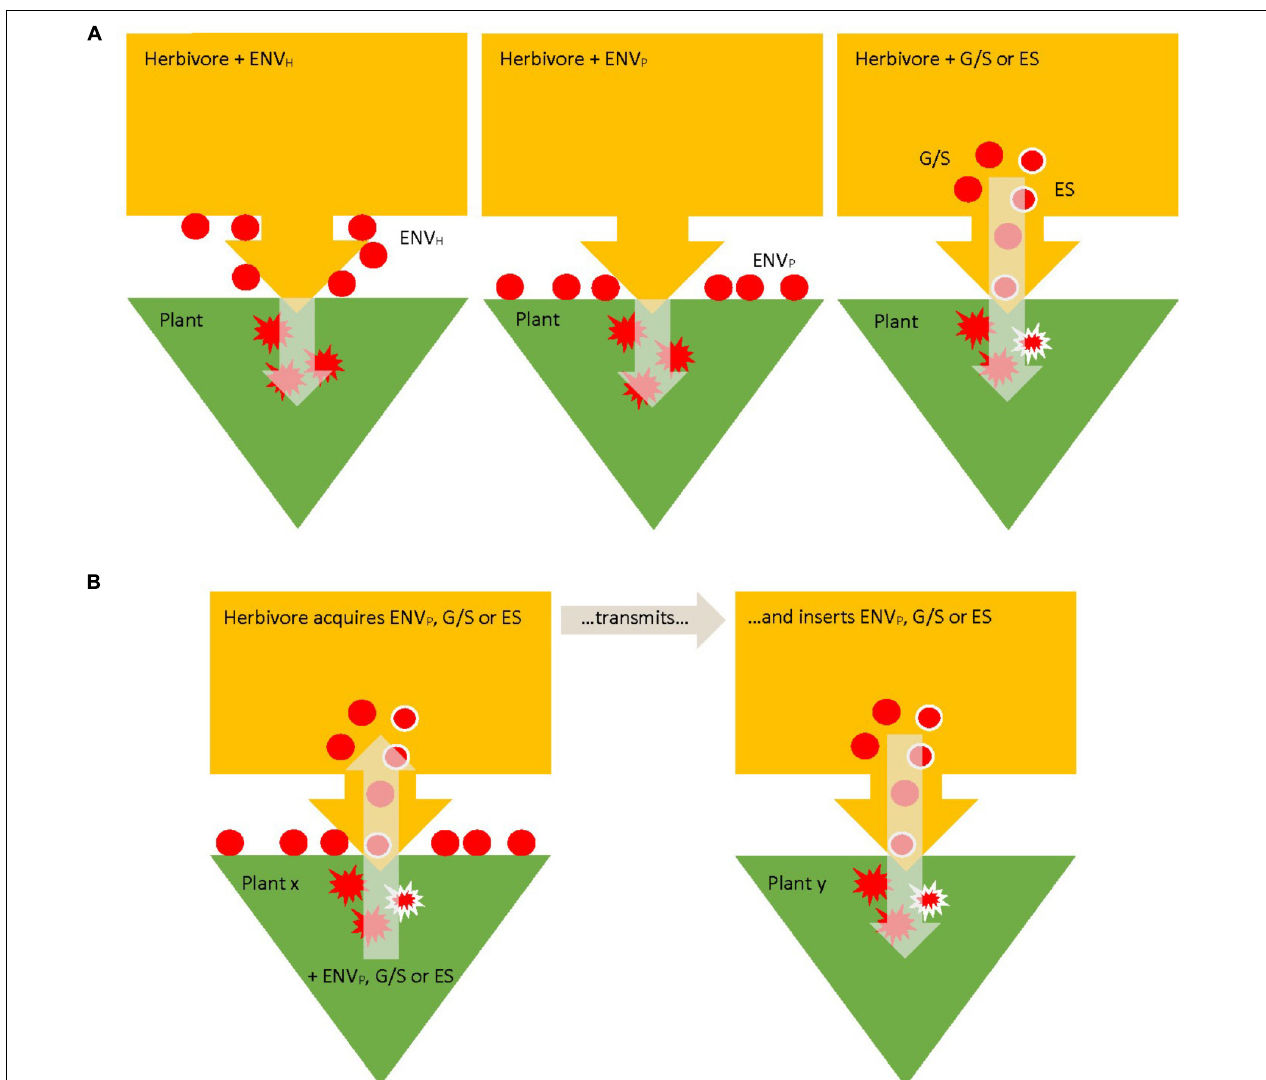
FIGURE 1 | Pathways of transmission of herbivore (yellow)-associated bacteria (HAB; red) to their host plants (green). HAB may be environmental (ENV H , P ; on the outside of the herbivore or plant), in the gut/saliva (G/S), or intracellular endosymbionts (ES; red with white margin), based on their location relative to the herbivore body. Circles symbolize HAB possibly involved in induced plant defense; splashes symbolize HAB activity in induced plant defense inside plant tissue. HAB may be intrinsically associated with the herbivores, either at the herbivore/plant interface or inside the herbivores (A) or may be acquired from plants and transmitted to other plants (B)